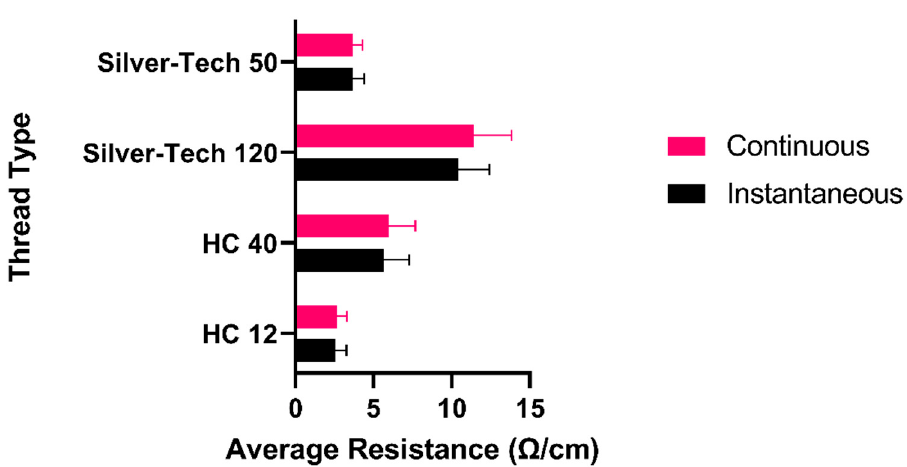
Figure 4. Average measured resistance per thread and per mode of testing.